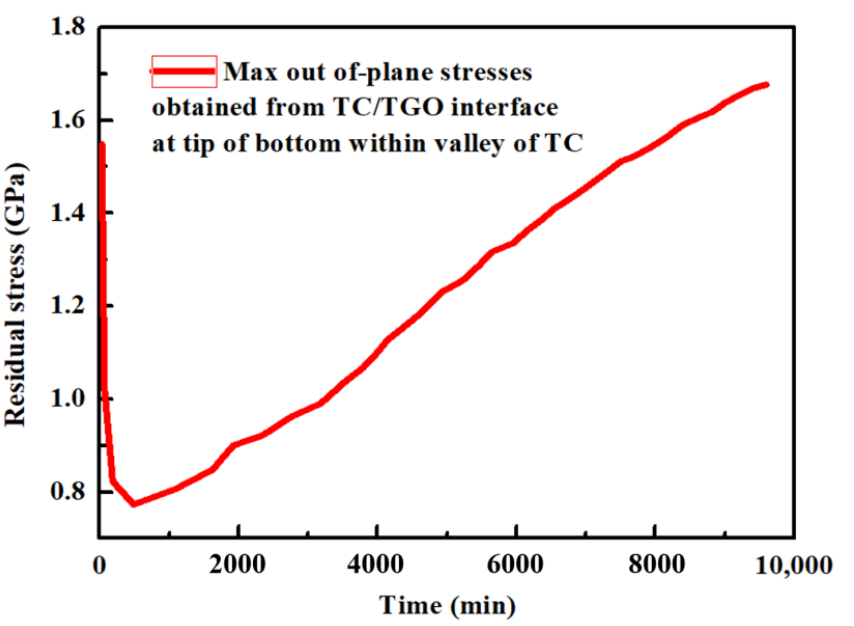
Figure 39. Valley stress at the tip of the bottom at the valley of the TC obtained. from the generalized roughness approximated